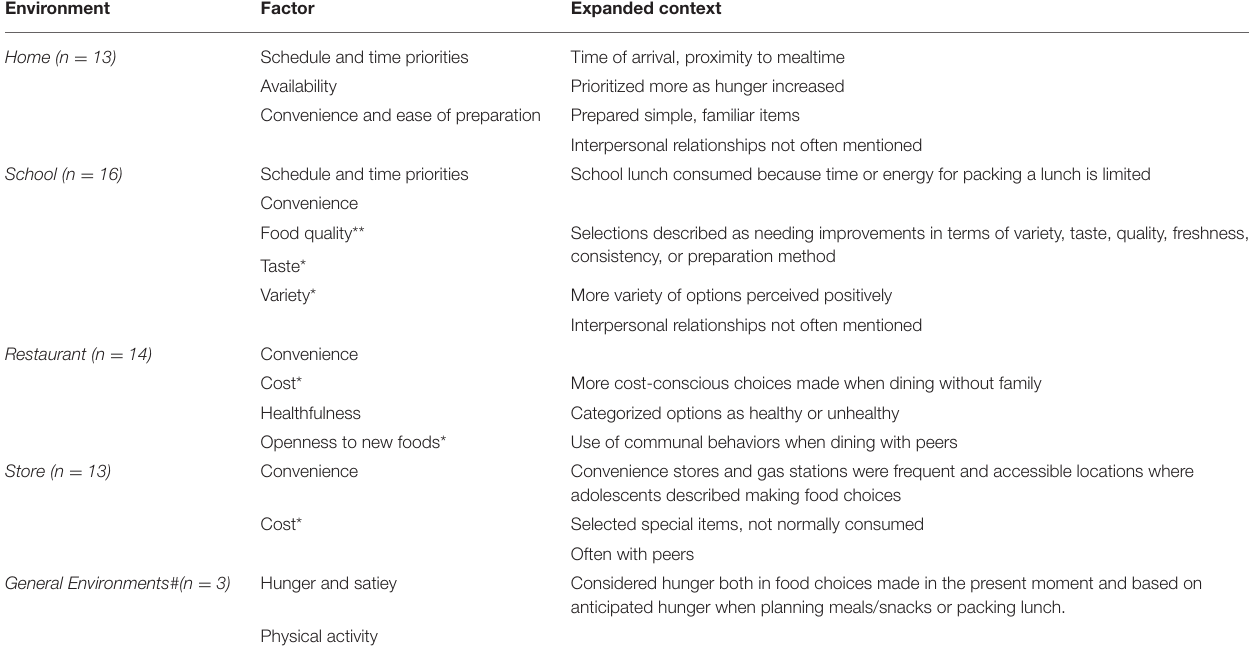
TABLE 2 | Summary of factors influencing adolescents’ food choices by environment.